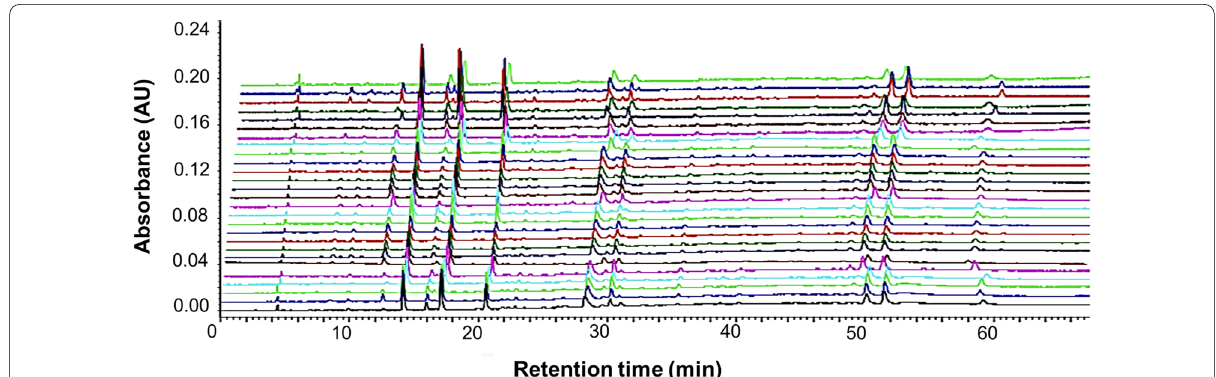
Fig. 5 Total chromatograms of 27 PMM batches with similar patterns between different